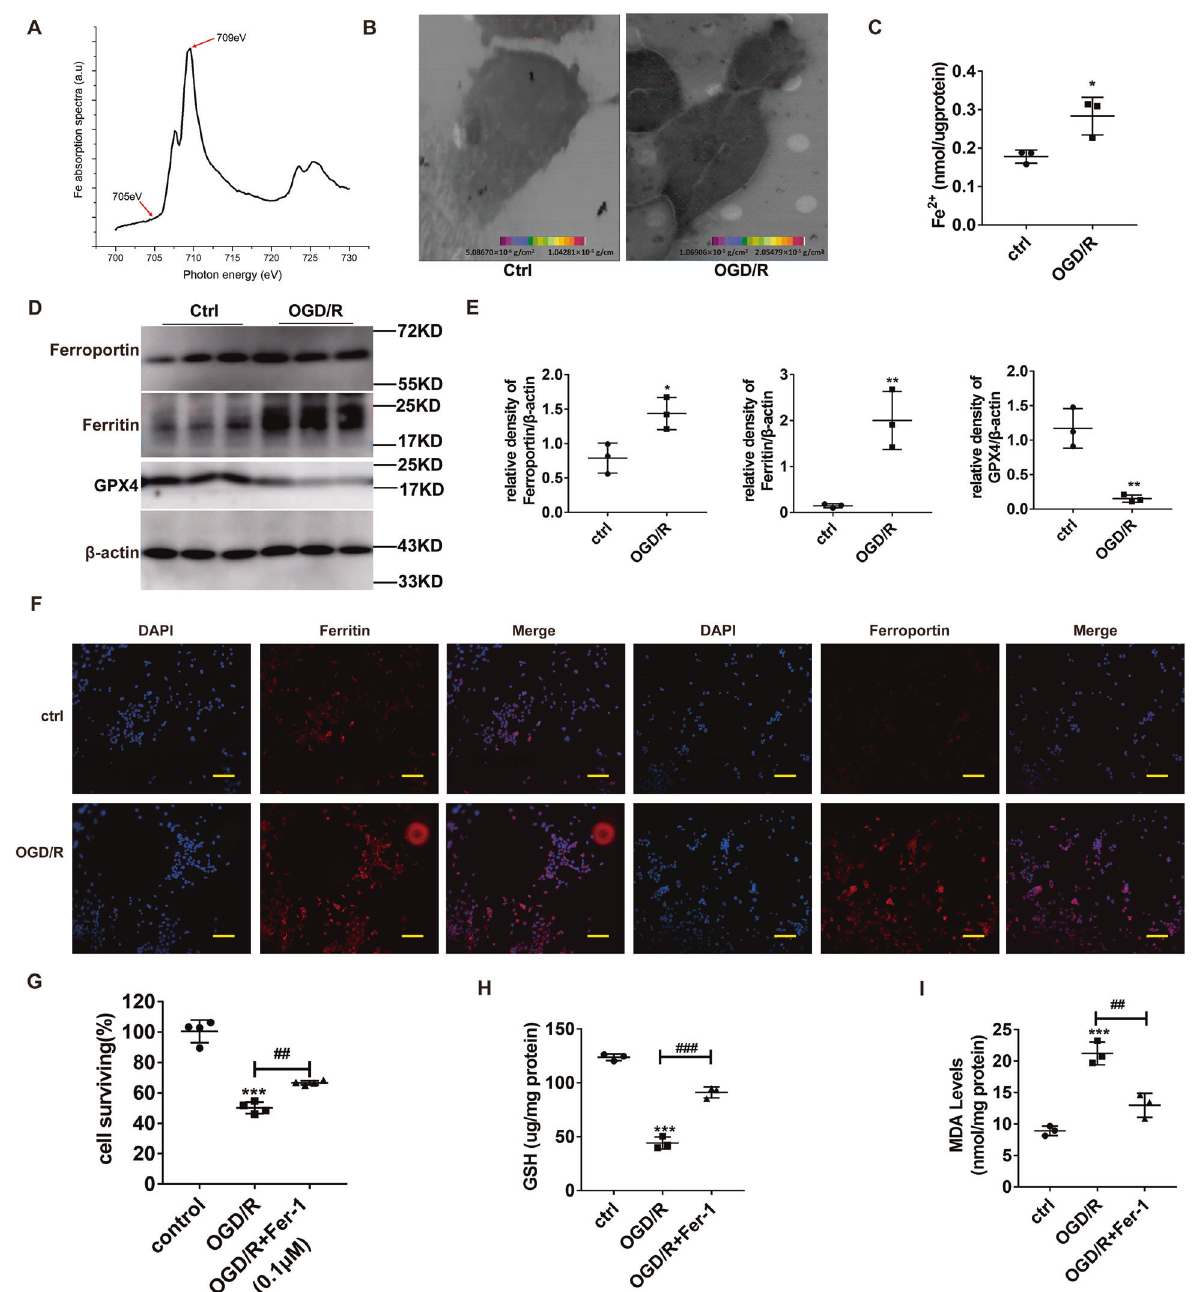
Fig. 3 OGD/R accelerates ferroptosis within pulmonary epithelial cells and enhances Nrf2, TERT, and SLC7A11 levels during ferroptosis. A Fe L3-edge NEXAFS (near edge X-ray absorption fi ne structure) spectrum was acquired from two absorption cellular images scanned at two energies, E 1 (709 eV) and E 2 (705 eV) above and below the absorption edge of Fe, respectively. B Evaluation of Fe distribution and content using scanning transmission X-ray microscopy. C Endogenous Fe levels within the pulmonary epithelial cells of the OGD/R model, as detected by Fe assay. D Evaluation of the levels of ferroptosis-related proteins under different conditions. E Quanti fi cation of the examined proteins. F Evaluation of ferritin and ferroportin levels (red) in lung tissues, using immunohistochemistry. Nuclear staining done with DAPI (blue) after OGD/R. Scale bar: 100 μ m. G Cell survival after OGD/R induction and the opposite effect with Fer-1 (0.1 μ M). H GSH levels under different conditions. I MDA levels under different conditions. Error bars denote standard error from three individual experiments. Data are expressed as mean ± SEM. * P < 0.05; ** P < 0.01; *** P < 0.001; *relative to control; # relative to ferroptosis process. To further examine ferroptosis activation in the IIR model, we introduced Fer-1, a speci fi c inhibitor, into the murine tail vein and harvested lung tissue at the end of the experiment. We revealed via HE staining (Fig. 1G) that Fer-1 dramatically decreased the severity of damage in the IIR mice lung tissue, compared to untreated IIR mice. Simultaneously, the MDA